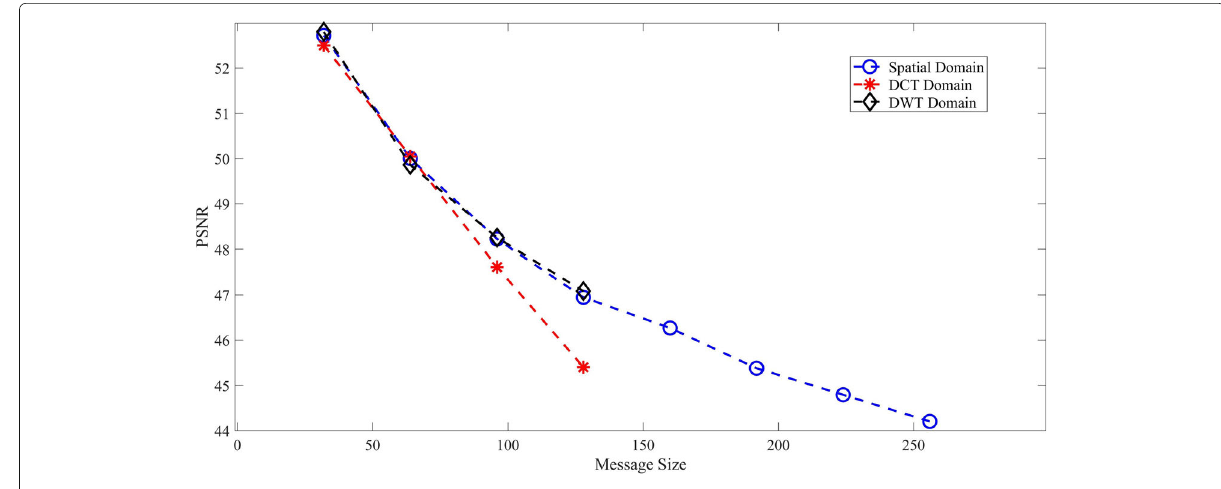
Fig. 9 PSNR vs message size (averaged over 50 images)